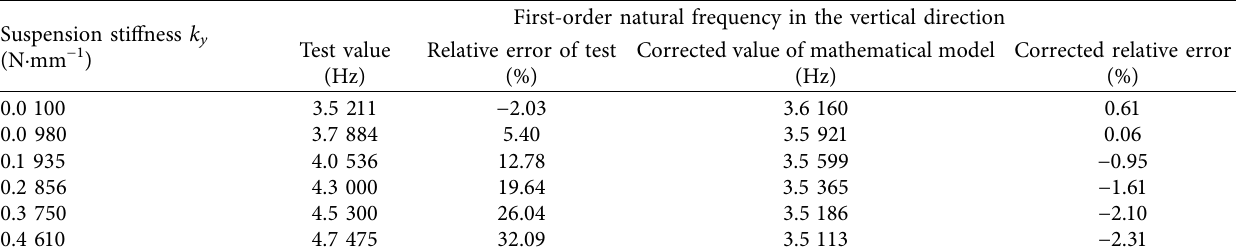
Table 3: Natural frequencies of the twofold solar array in the vertical direction. First-order natural frequency in the vertical Suspension stiffness k y (N · mm − 1 )